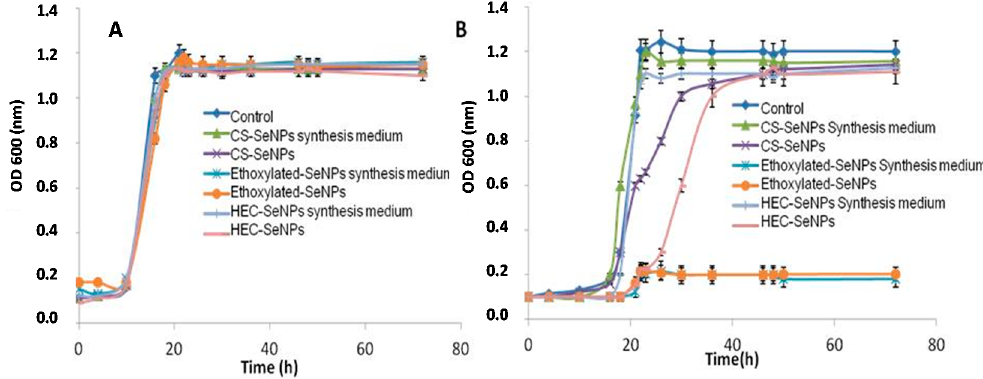
Figure 2. Effect of SeNPs and selenite on bacteria growth and accumulation. Bacteria growth curve in presence of SeNPs at two levels of exposure ( A ) 1 µ g Se mL − 1 and ( B ) 10 µ g Se mL − 1 . Data are expressed as mean ± standard error N = 3 replicates.